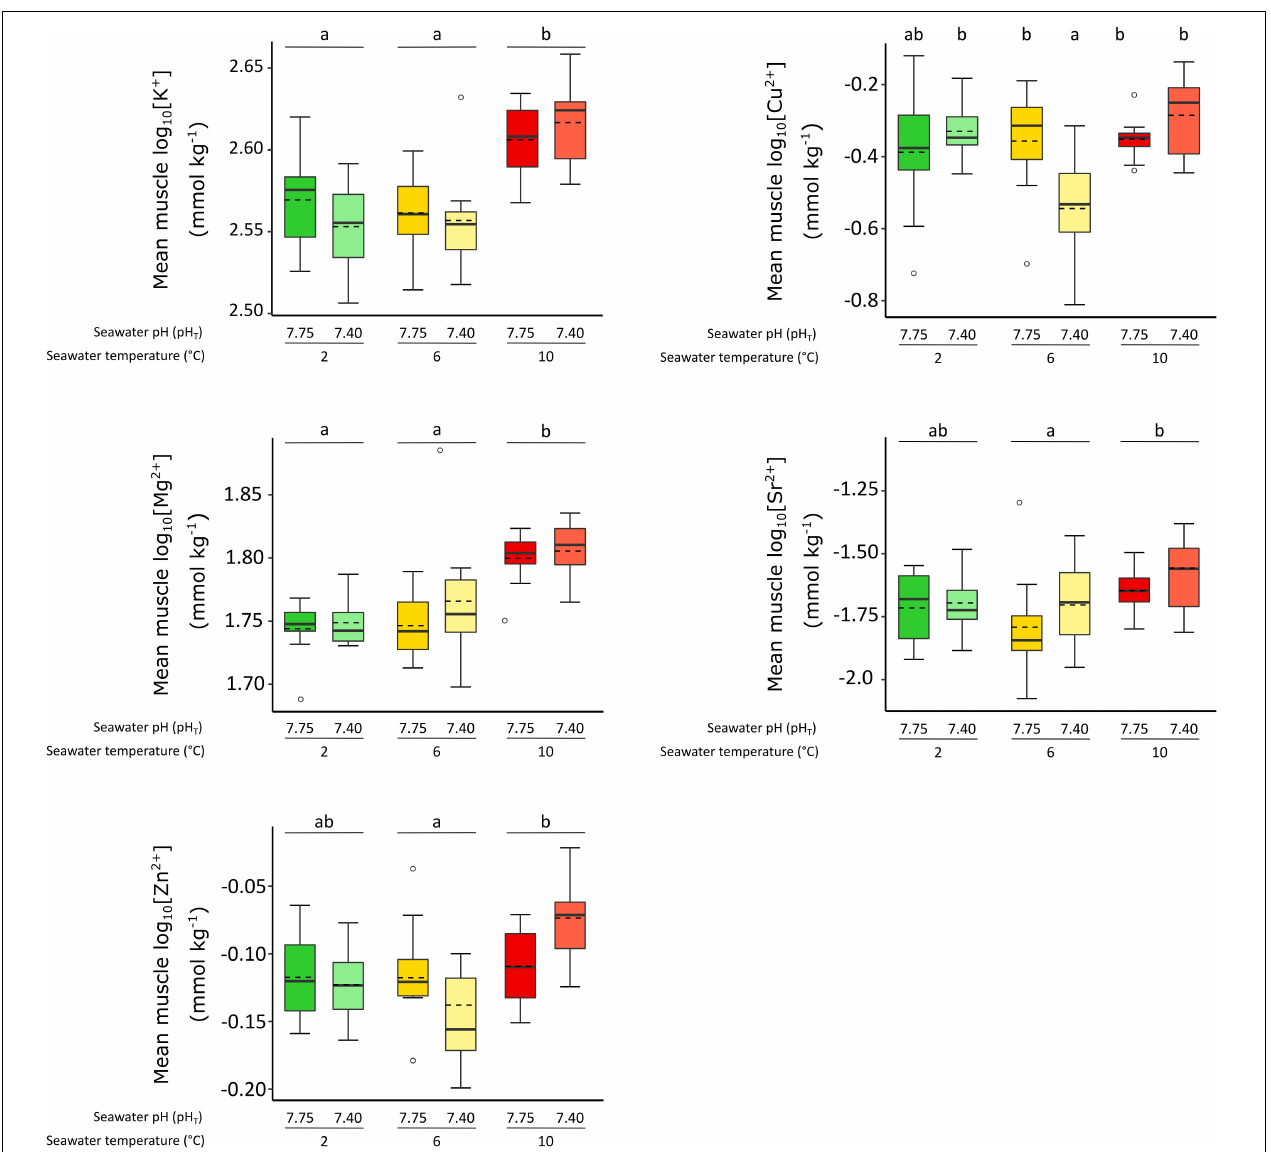
FIGURE 2 | The effect of exposure to elevated temperature and low pH in isolation and combined for 30 days on mean muscle log 10 [K + ], [Cu 2 + ], [Mg 2 + ], [Sr 2 + ], [Zn 2 + ] (mmol kg − 1 ± SE) of female P. borealis . Box plots represent different treatment, with plain lines indicating the median, dotted lines representing the mean. Lower case letters identify significant differences ( p < 0.05) between treatments, empty circles represent extreme values exceeding the 95% quantile for each